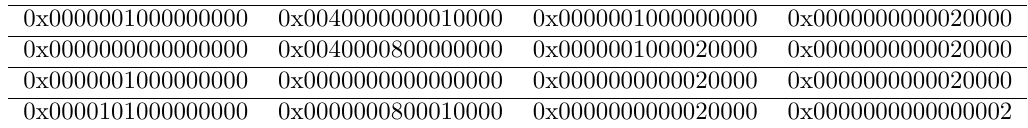
Table 5: Input difference in Phase